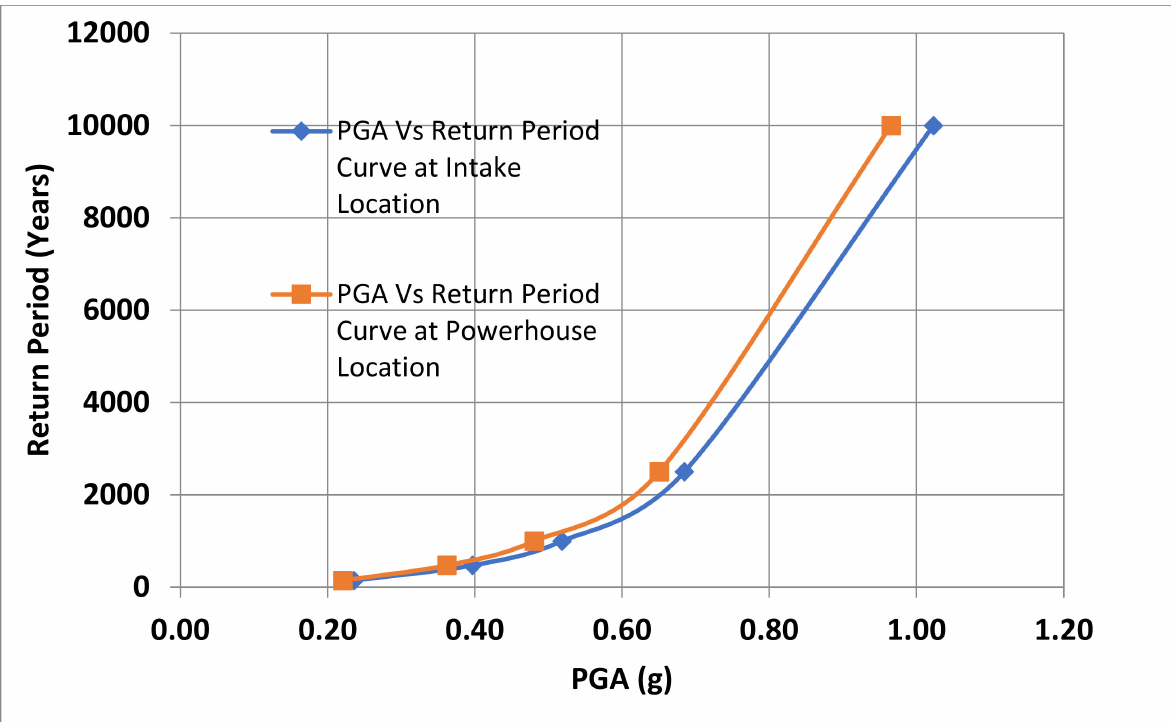
Figure 15. PGA versus return period for the intake and the powerhouse of the Shigo Kas HPP.